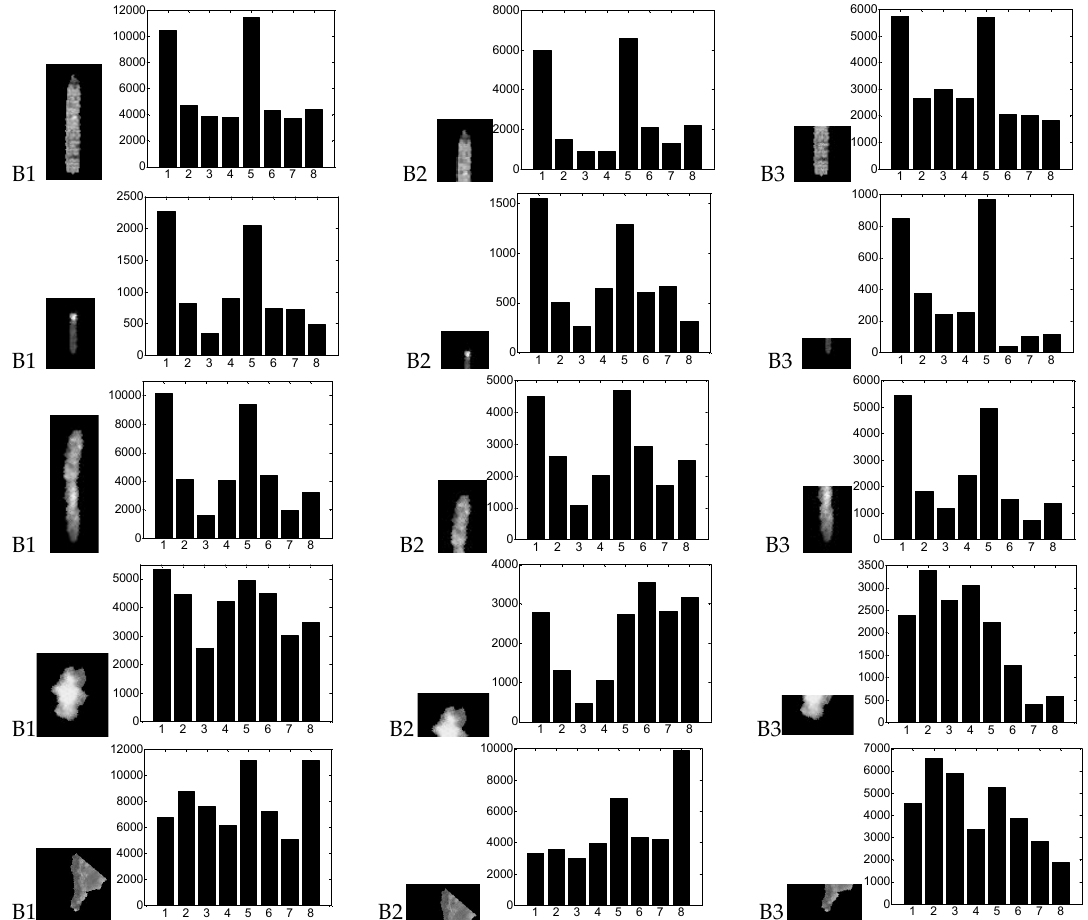
Figure 10. Histogram statistics of the three blocks for eight bins: (from top to down) big ship, small ship, ship with wake, cloud and island.